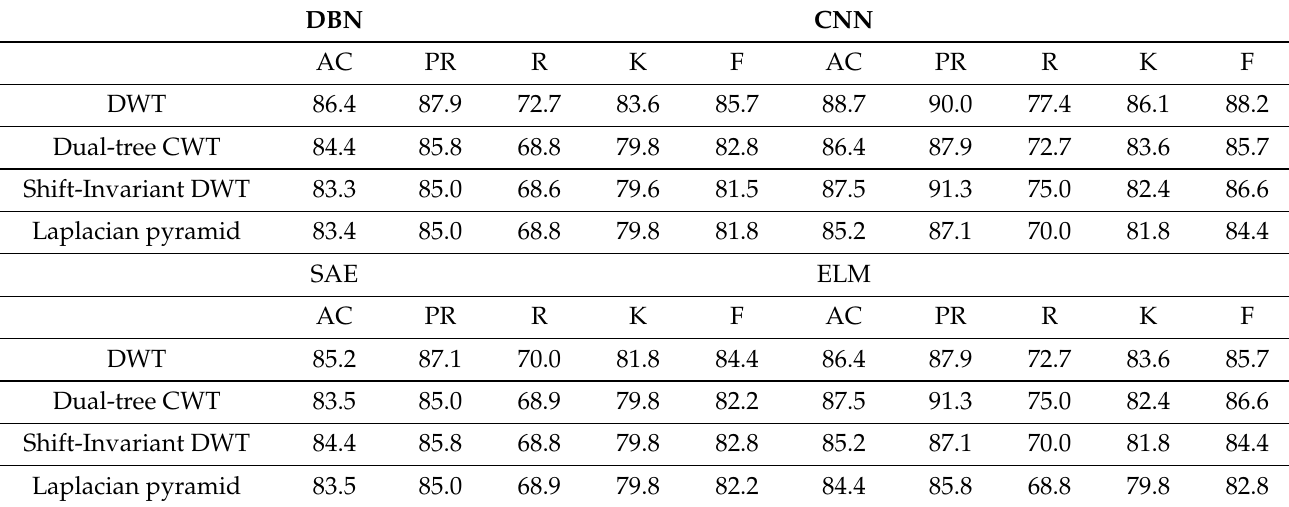
Table 5. Accuracy (AC), Precision (PR), Recall (R), Cohens kappa (K), and F-measure (F) values in percentage for the analyzed spatial fusion methods and classification algorithms using frequency fused data as